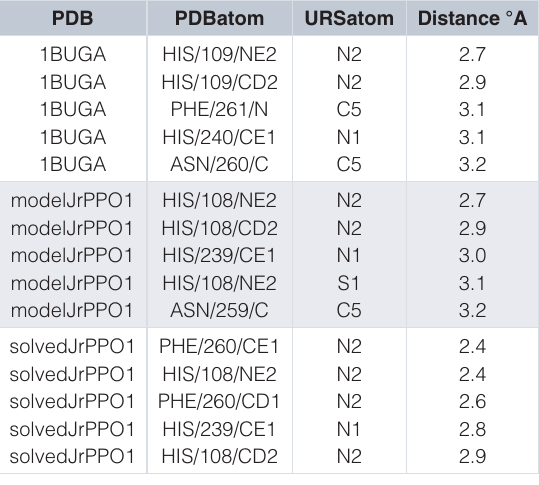
Table 7. Docking phenylthiourea (URS) to modelled (modelJrPPO1) and solved (solved- JrPPO1,PDBid:5CE9A) polyphenol oxidase (PPO) from walnut: JrPPO1 has been modelled using the PPO from Ipomoea batatas (sweet potato), where URS is liganded by His109/His240/Phe261/Asn260. After DOCLASP docking, modelledJrPPO1 has the analogous His108/ His239/Asn259 as binding residues, while solvedJrPPO1 has His108/His239/Phe260 as binding